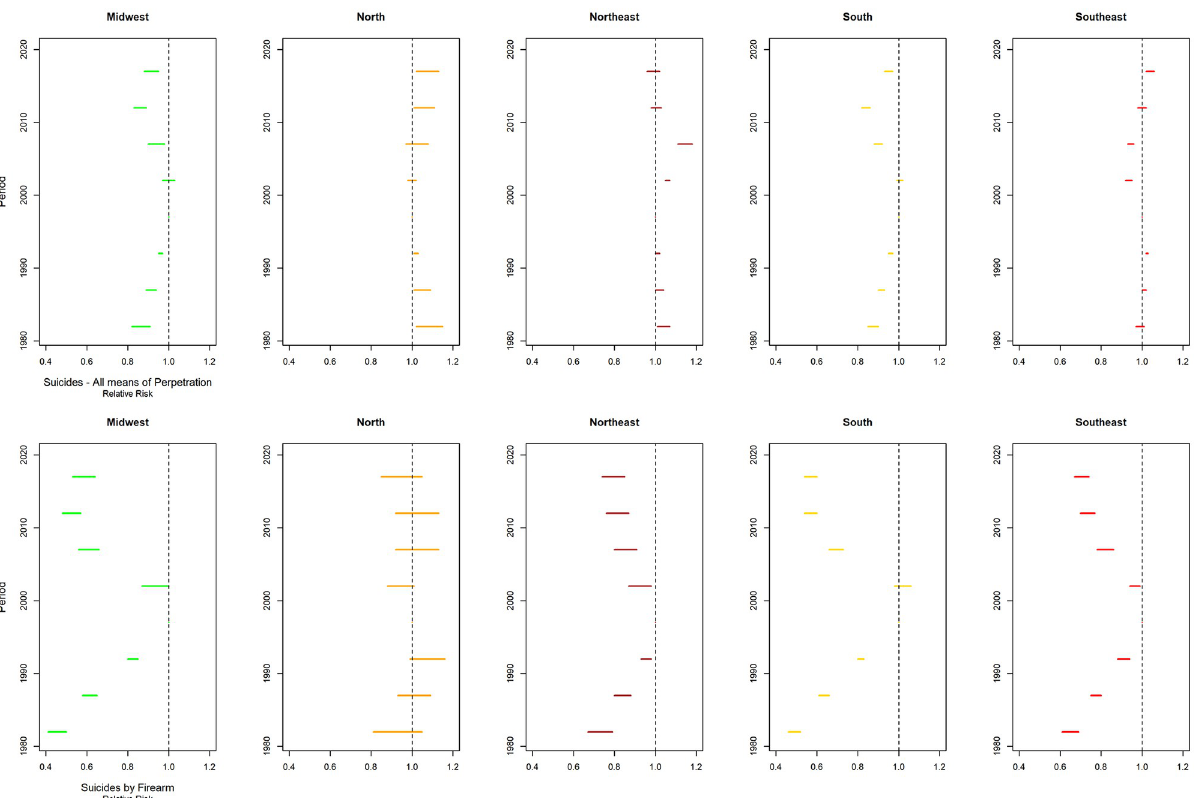
Fig 7. Risk of death (relative risk) by period, adjusted for age and cohort effect, for total suicide and suicide by firearms, from 1980 to 2019, Brazil and major regions.